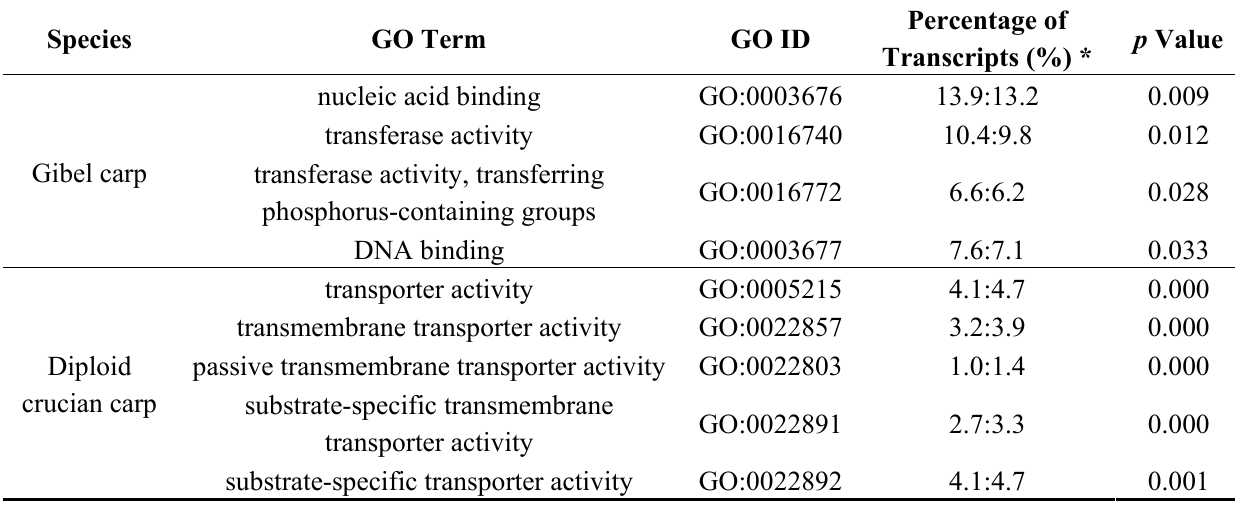
Table 2. The enriched molecular functions in gibel carp and diploid crucian carp ( p value < 0.05). Species